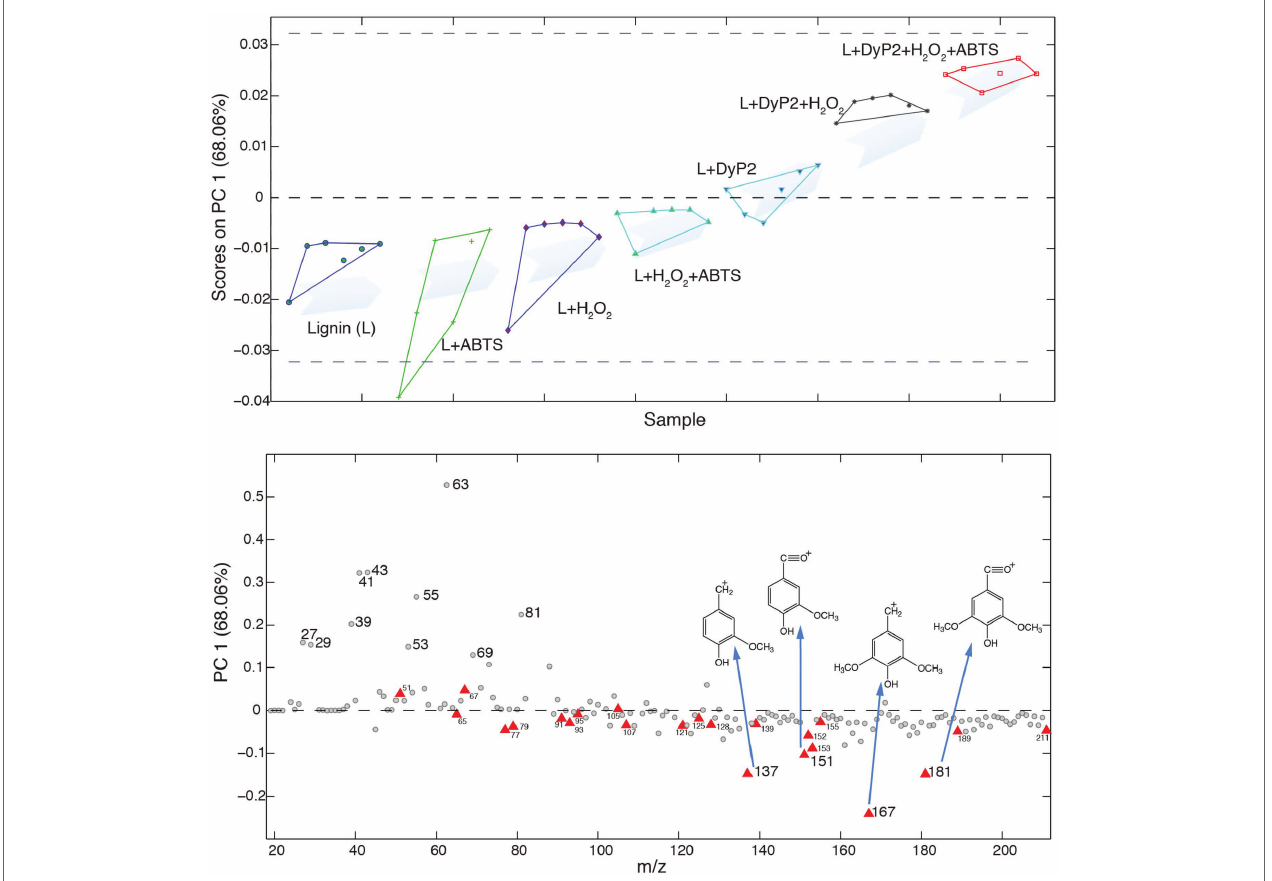
FIGURE 5 | ABTS enhanced lignin modification of DyP2 on organosolv lignin. PC1 score (top) and PC1 loading (bottom) of six lignin treatments ( n = 6). Boundaries of ToF-SIMS acquisition data of each treatment are shown by lines. Lignin peaks are highlighted as red triangles, and the structures of lignin peaks that contributed most to clustering are inserted in the PC1 loading chart and highlighted by blue